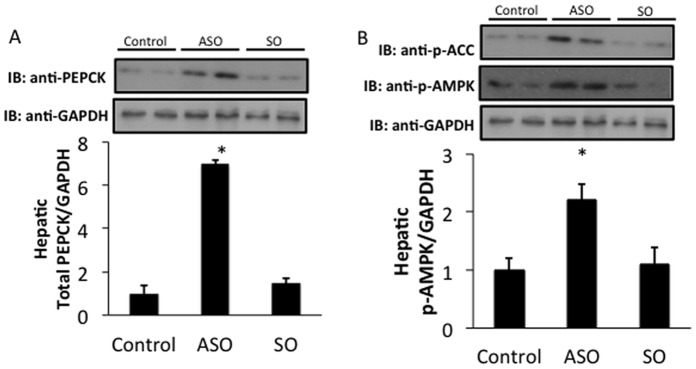
Liver PEPCK expression and AMPK/ACC phosphorylation in ASO-ACC and ACC-SO mice.Representative western blot of PEPCK (A). Bars show quantification of total PEPCK protein normalized by total GAPDH. Representative western blot of p-AMPK and p-ACC protein normalized by total GAPDH (B). Data are means ± SEM of 4–6 rats. *p≤0.05 vs. control and ACC-SO rats.